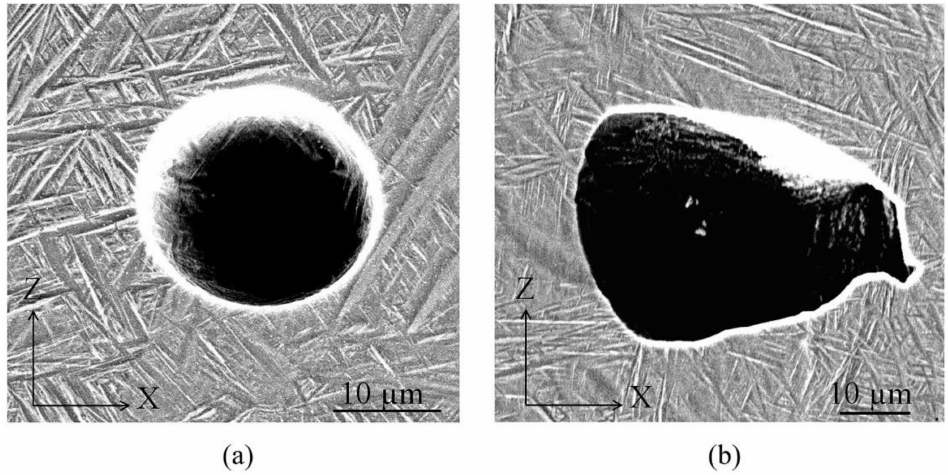
Figure 16. Porosity defects found in SLM Ti-6Al-4V specimens ( a ) spherical gas pore, ( b ) oblate spher- ical pore. The build direction is in Z-axis. Reprinted with permission from ref. [77]. 2018,